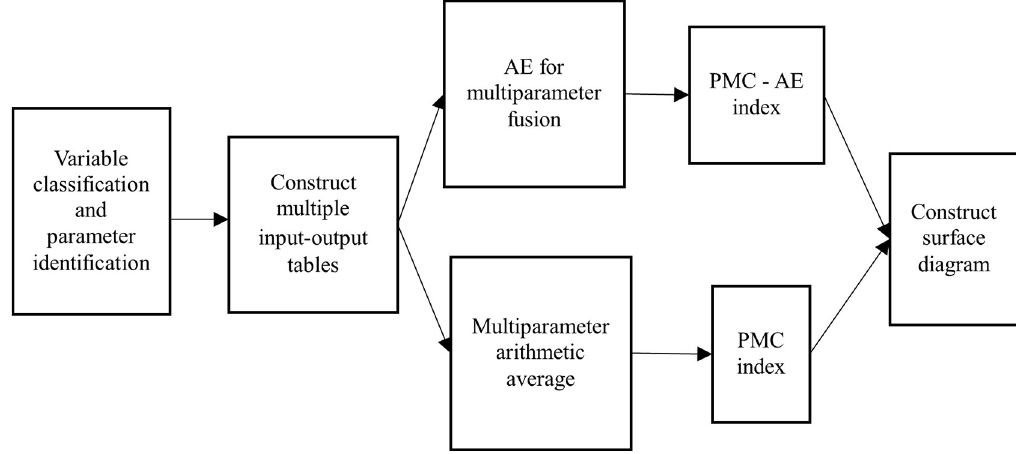
Fig 2. Comparison of PMC-AE index model with PMC index